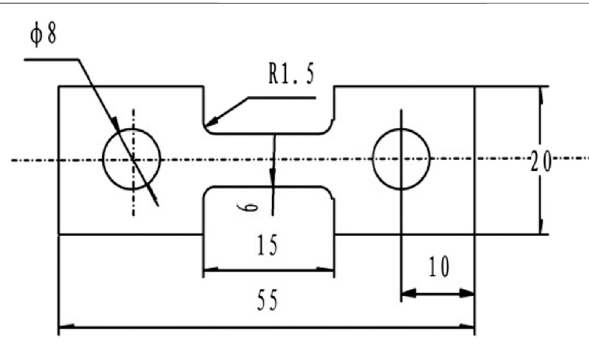
FIGURE 2 | Schematic diagram of tensile specimen dimension (unit: